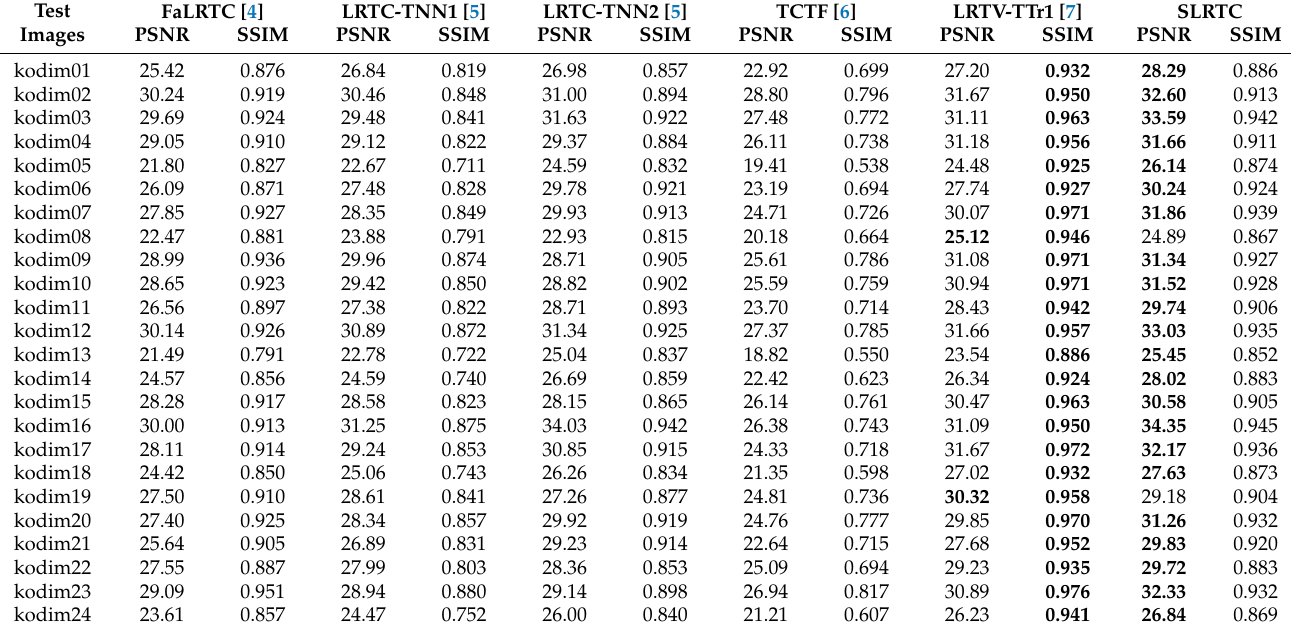
Table 4. The PSNR and SSIM Comparison of different methods on the Kodak PhotoCD dataset, the incomplete images tested contain 70 percent missing entries (The best results are